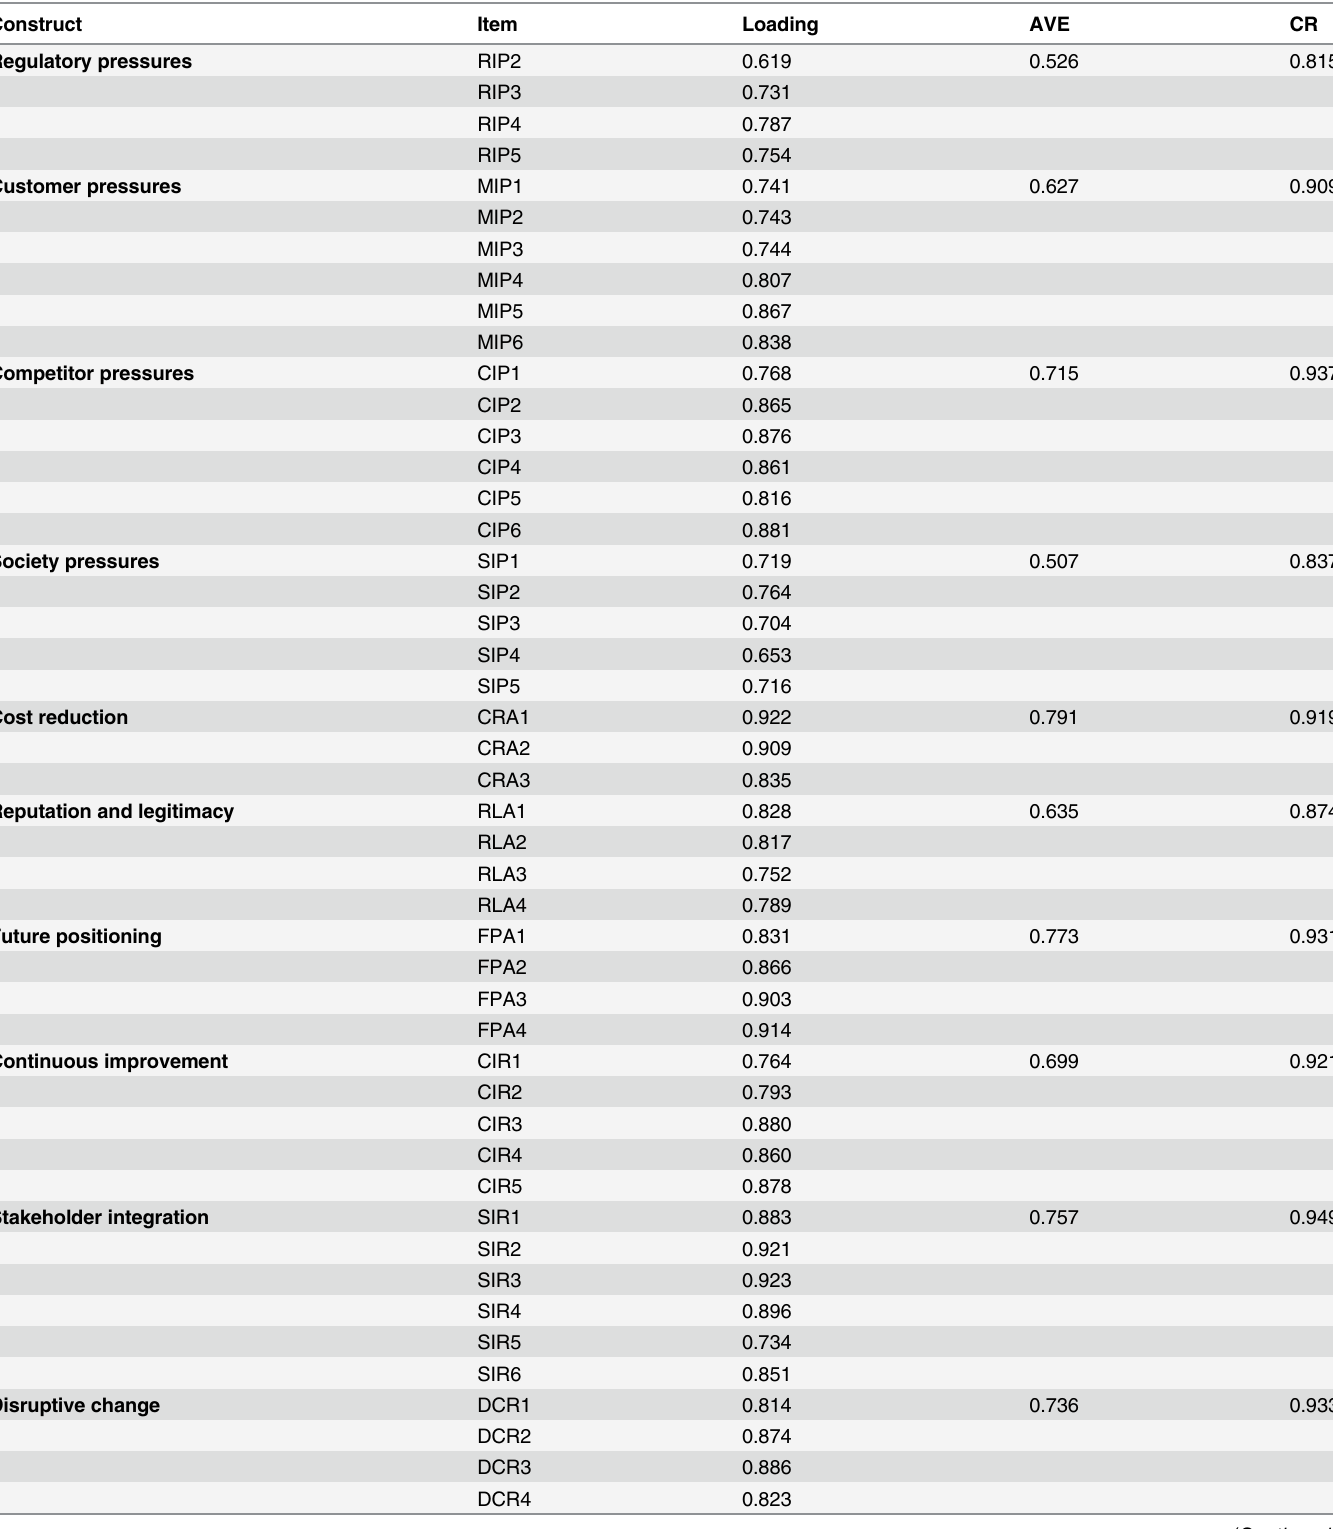
Table 3. Evaluation of reflective measurement